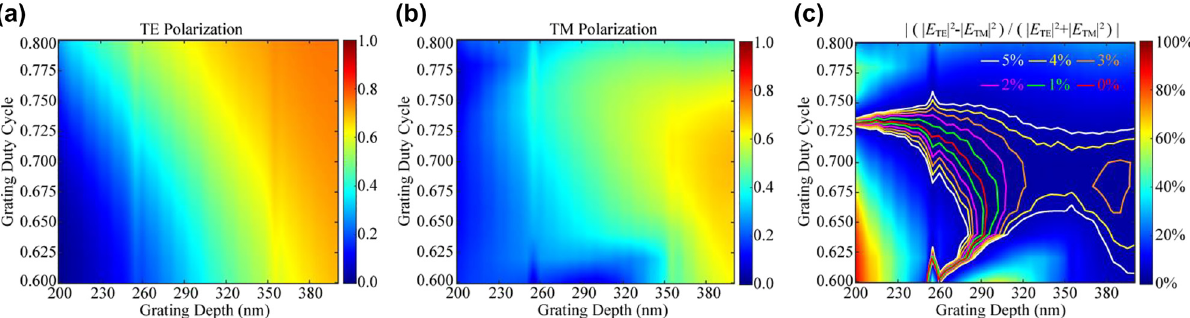
Figure 2: Diffraction efficiency of ( − 1, 0)-order diffracted light for the two-dimensional grating versus groove depth h and bottom duty cycle f under (a) transverse-electric (TE) and (b) transverse-magnetic (TM) polarization. (c) Evaluated imbalance of diffraction efficiency between TE and TM. Contour lines with different colours represent the levels of polarization-dependent diffraction